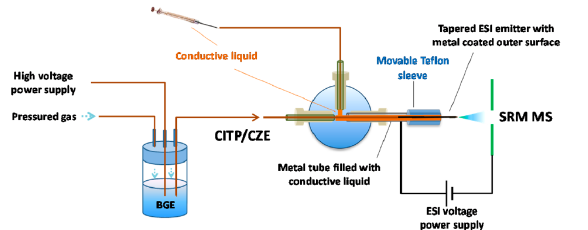
Figure 6 Schematic of the robust sheathless interface setup in our group. Reprinted with permission from reference